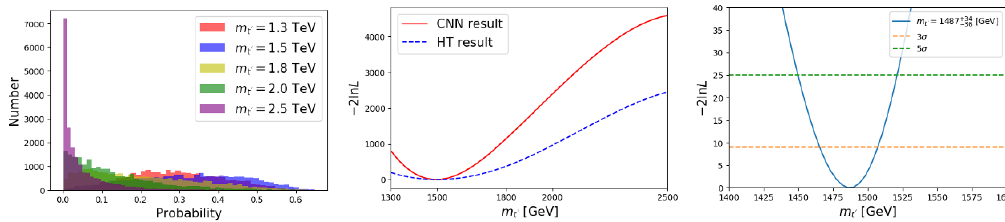
Figure 5 . Left panel: the CNN output for the 1.5 TeV classi(cid:12)er when fed events corresponding to di(cid:11)erent values of m t 0 as indicated. Middle panel: the (cid:0) 2 ln L constructed from the distribution from CNN output (red) and the H T distribution(blue) aimed for m t 0 = 1 : 5 TeV as a function of the hypothesized mass. Right panel: the (cid:0) 2 ln L analysis around m